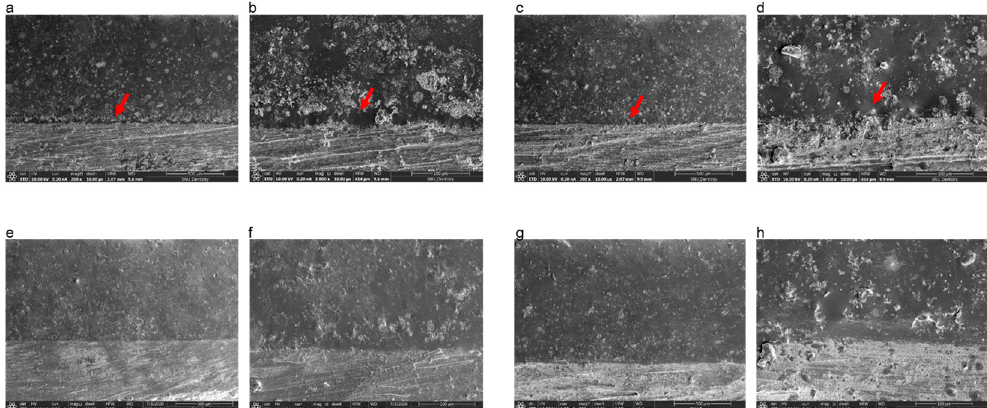
Figure 4. Scanning electron microscopy images of the Co-Cr and ceramic interface after sputtering with Au due to the low conductivity of ceramic. ( a ) Casted specimen, magnification 200 × ; ( b ) casted specimen, magnification 1000 × ; ( c ) SLM-fabricated specimen without bonding agents, magnification 200 × ; ( d ) SLM-fabricated specimen without bonding agents, magnification 1000 × ; ( e ) SLM-fabricated specimen with bonding agent A, magnification 200 × ; ( f ) SLM-fabricated specimen with bonding agent A, magnification 1000 × ; ( g ) SLM-fabricated specimen with bonding agent B, magnification 200 × ; ( h ) SLM-fabricated specimen with bonding agent B, 1000 × . The red arrows indicate the thick oxide layer that looks like a gap between ceramic and metal.